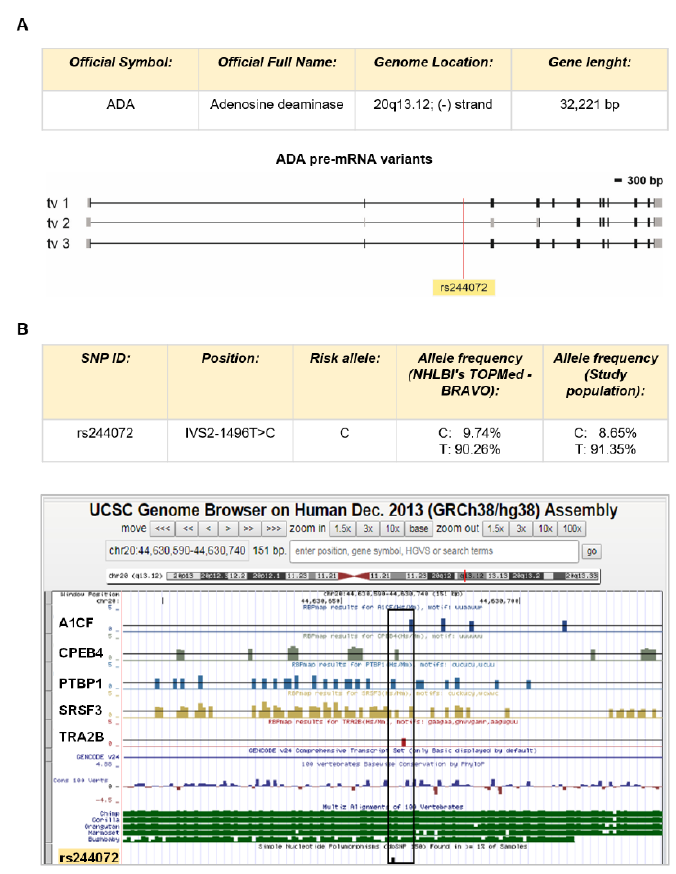
Figure 1. ADA gene and SNP rs244072. ( A ) Scheme of ADA gene. The ADA gene in humans is placed in the minus strand of the chromosome 20 (chr20:44,619,522–44,651,742 in human genome assembly Dec. 2013 GRCh38 / hg38). Three splicing variants coding for functional proteins (transcript variant 1 with ID NM_000022 = tv 1, transcript variant 2 with ID NM_001322050 = tv 2, transcript variant 3 with ID NM_00132205 = tv 3) are depicted according to NCBI annotations. Black rectangles represent coding regions in exons. Grey rectangles are untranslated regions in exons. Black lines are introns. “bp” means base pair. SNP rs244072 is located in the second intron of ADA gene and in all transcript variants. ( B ) Description of the ADA SNP rs244072. The SNP is 1496 bp upstream the end of second intron (chr20:44630665 in human genome assembly Dec. 2013 GRCh38 / hg38). Allele frequencies (C / T) from both European population from NHLBI’s TOPMed-BRAVO database (https: // bravo.sph.umich.edu / freeze5 / hg38 / variant / 20-44630665-A-G) and our sample population are reported. Bioinformatic analysis on ± 75 bp from rs244072 by using RBPmap revealed that the SNP is included in several RNA binding sites for di ff erent regulatory proteins of gene expression. UCSC representation of the RNA binding site is outlined. The black empty rectangle identifies the regulatory regions containing rs244072. RNA binding proteins’ ID are indicated on the left (A1CF = APOBEC1 Complementation Factor; CPEB4 = cytoplasmic polyadenylation element binding protein 4; PTBP1 = Polypyrimidine Tract Binding Protein 1; SRSF3 = Serine and arginine Rich Splicing Factor 3; TRA2B = TRAnsformer 2 β